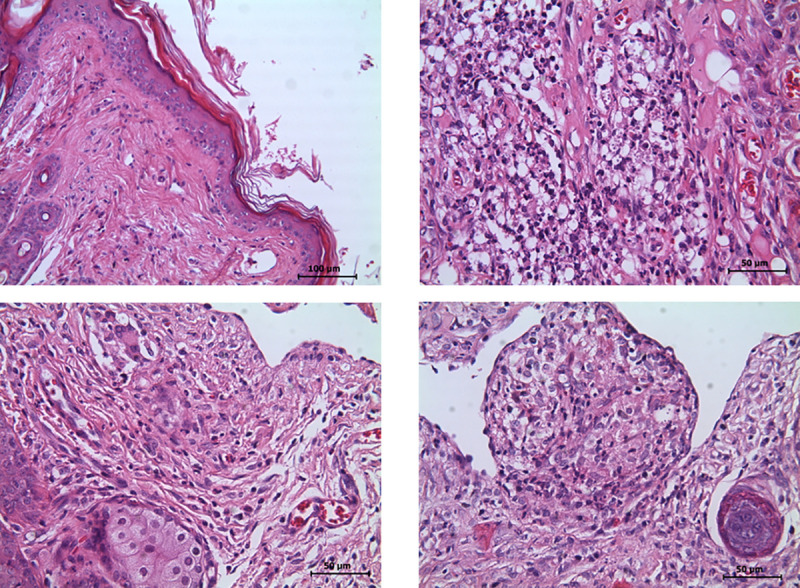
Histopathology of the skin of infected hamsters treated with compounds 2 and 8.(a) Skin of cured hamsters treated with compound 2, (b) skin showing improvement, and skin of hamsters treated with compound 8, showing (c) cure or (d) improvement: hematoxylin/eosin method; 50–100 μm magnification.